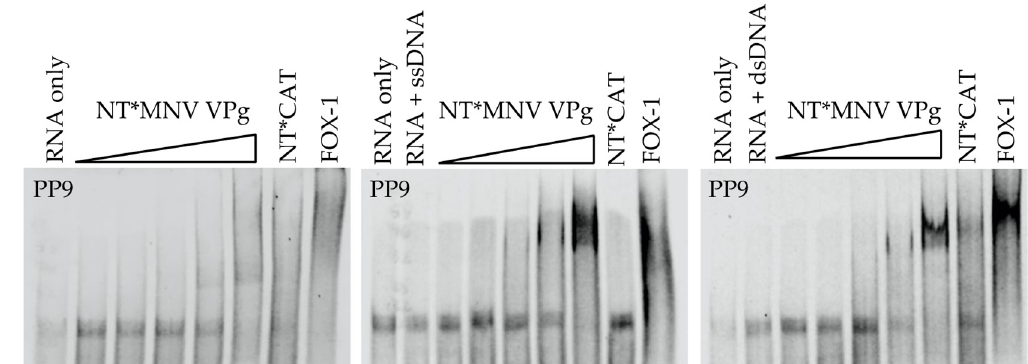
Figure 4. NT*MNV VPg preferentially binds RNA. NT*MNV VPg was incubated with 100 nM UTP ATTO 680 labelled pentaprobe RNA and a 100-fold molar excess of either single-stranded or double-stranded unlabelled DNA probe for 30 min. The concentration of NT*MNV VPg was increased from 0.5 μ M to 8 μ M in 2-fold increments, as shown by a gradient triangle. NT*CAT (8 μ M) and FOX-1 (8 μ M) were included as negative and positive controls, respectively.